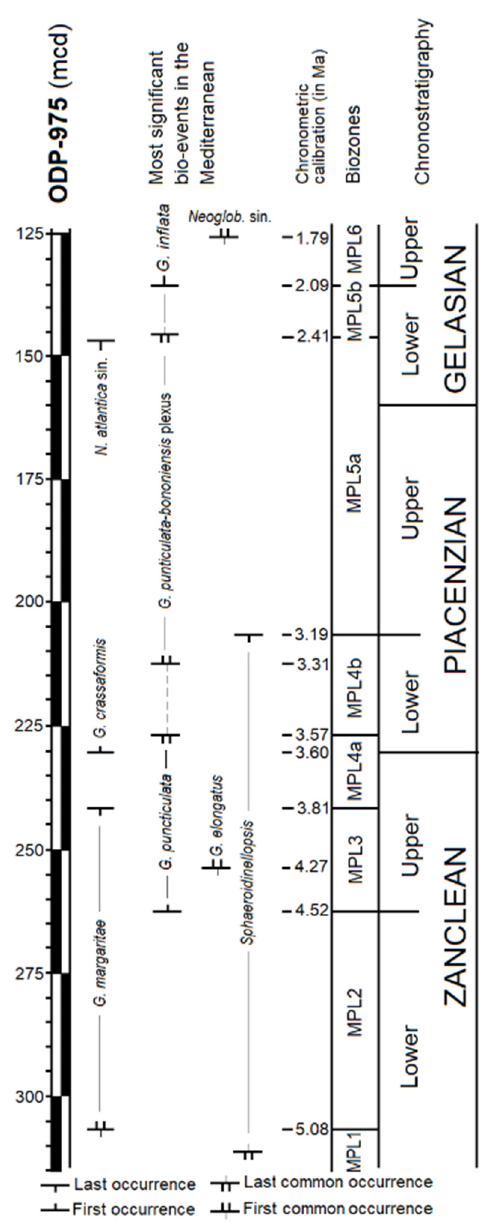
Figure 6. Chronologic monitoring of the Pliocene–Gelasian sedimentation at ODP-site 975 based on planktonic foraminifera. Biozones by [45], amended by [46]. planktonic foraminifera. Biozones by [45], amended by